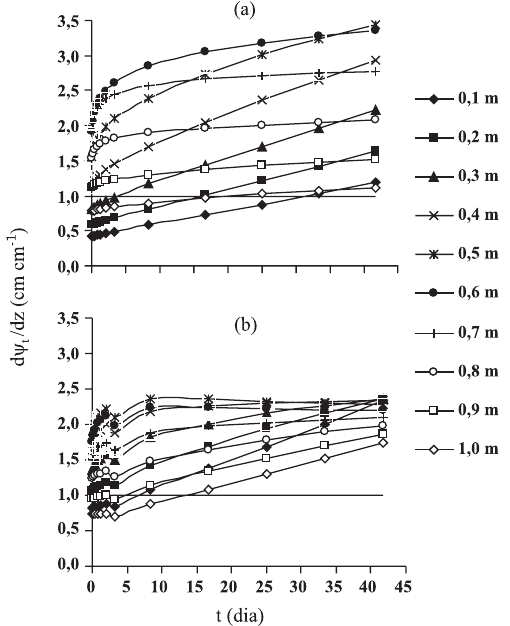
Figura 5. Evolução do gradiente hidráulico com o tempo no perfil do solo. Destaca-se d ψψψψψ para ter como referência (linha mais grossa, horizontal, sem